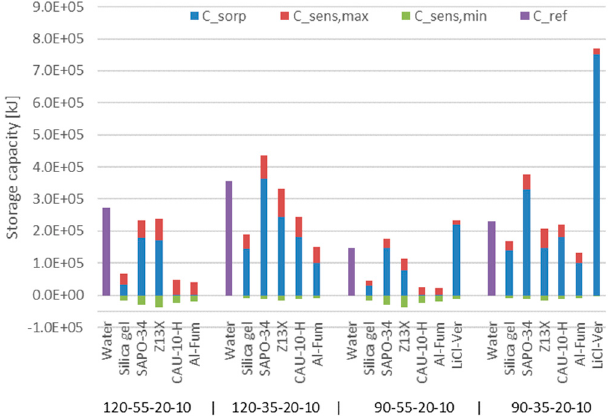
Figure 10. Storage capacity of 1 m 3 storages with the selected materials under different boundary conditions (T des -T ads -T cond -T evap ). conditions (T des -T ads -T cond -T evap